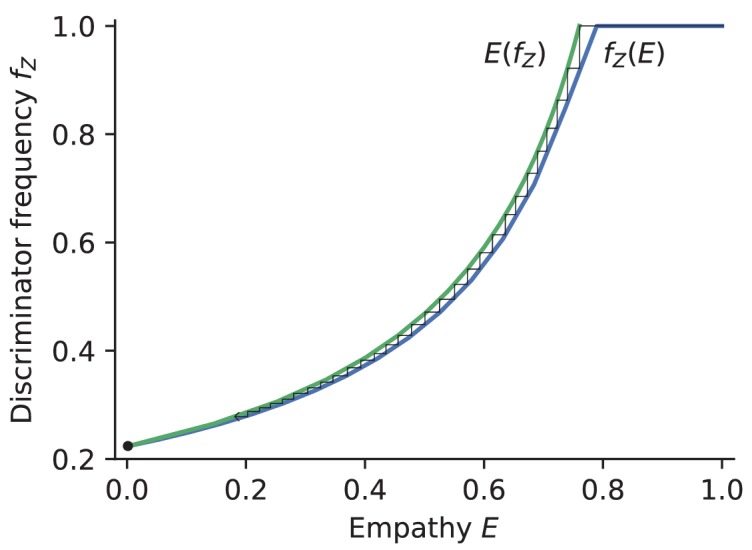
Empathy-strategy co-evolution in an infinite population under Simple Standing norm.The figure combines the equilibria analysis in the replicator dynamics for strategy evolution given fixed empathy, fZ⁢(E); and singular-point analysis in pairwise invasibility plots for empathy evolution, E⁢(fZ). We make no assumption about the timescales of the two mutational processes. The only fixed point across the two models is E=0.